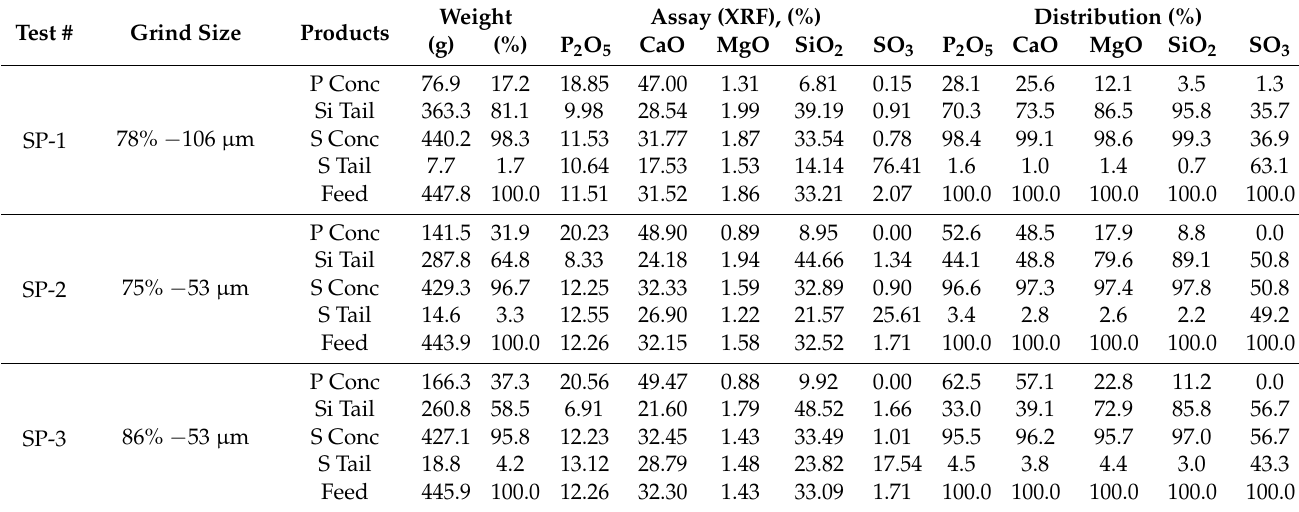
Table 2. The results of grinding-flotation tests on skarn